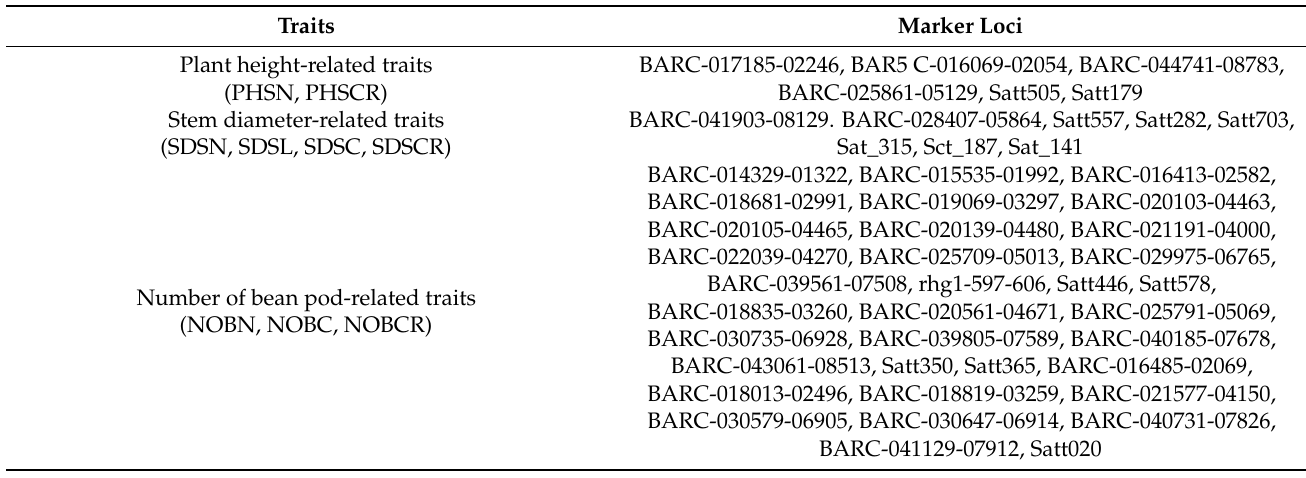
Table 5. Markers related to the plant height, stem diameter, and number of bean pods after low-light